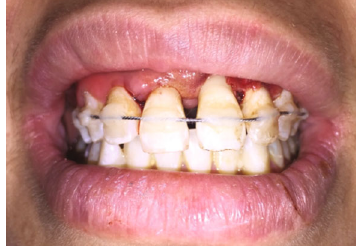
Figure 4: Immediate replanted and splinted teeth 11, 21, and 22. A fl exible splint stabilized teeth for 4 weeks.